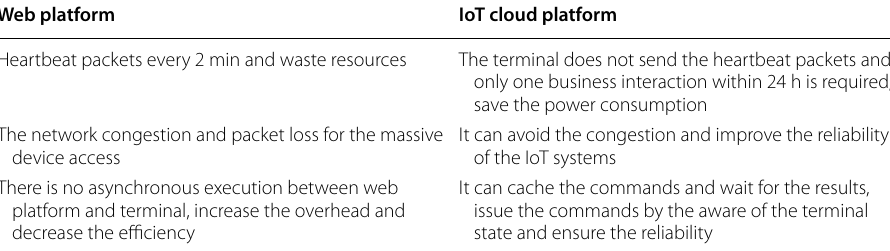
Table 1 Comparative analysis of terminal access methods Web